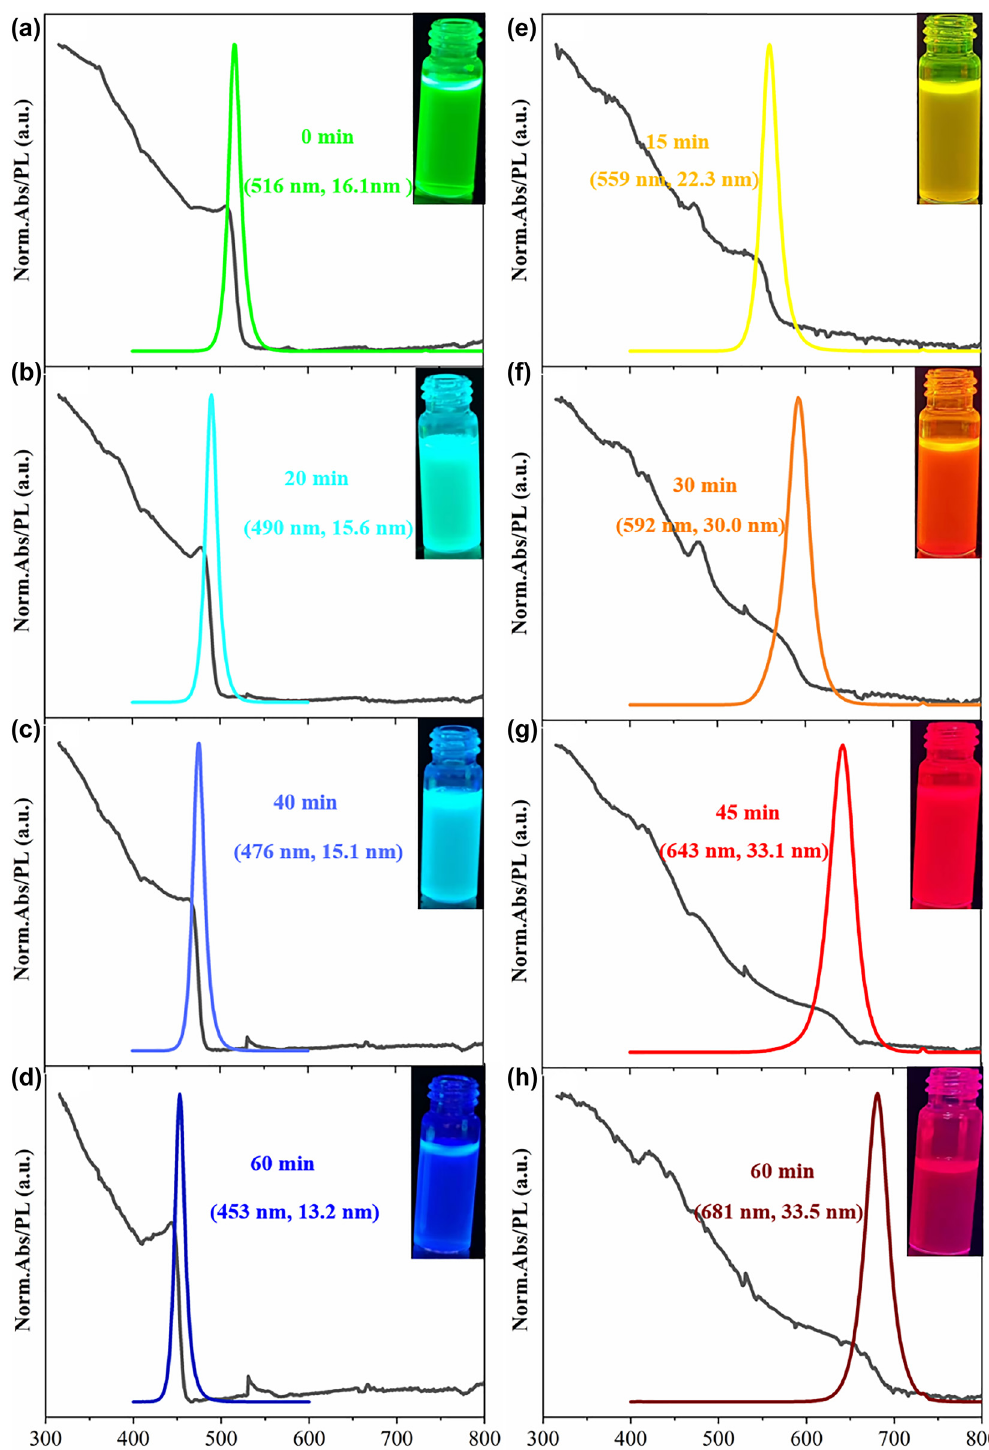
Figure 3: Absorption and PL spectra of the mixture of anion exchange resin and CsPbBr 3 PQDs at different reaction times. (a) – (d) Type-Clanion exchange resinparticipates in the reaction.(e) – (h) Type-I anion exchange resinparticipates inthe reaction. Insets show the corresponding